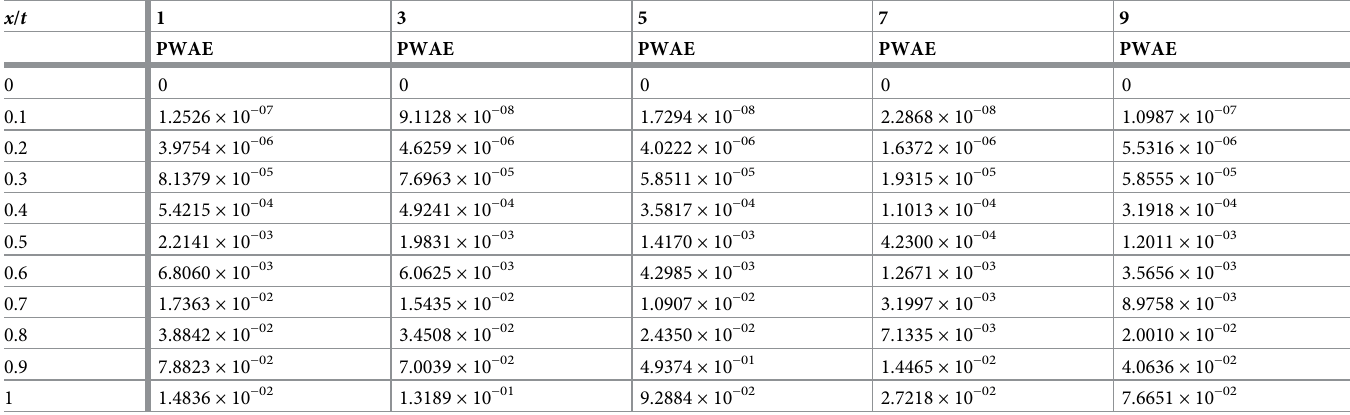
Table 1. The PWAEs for Γ = 16, Δ t = 10 − 02 , b = 0.2 and � k ¼ 0 : 35 for Test Problem 1.